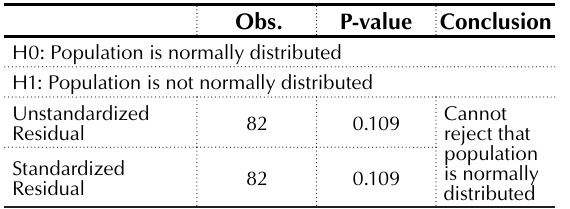
Table 8. Variables descriptive